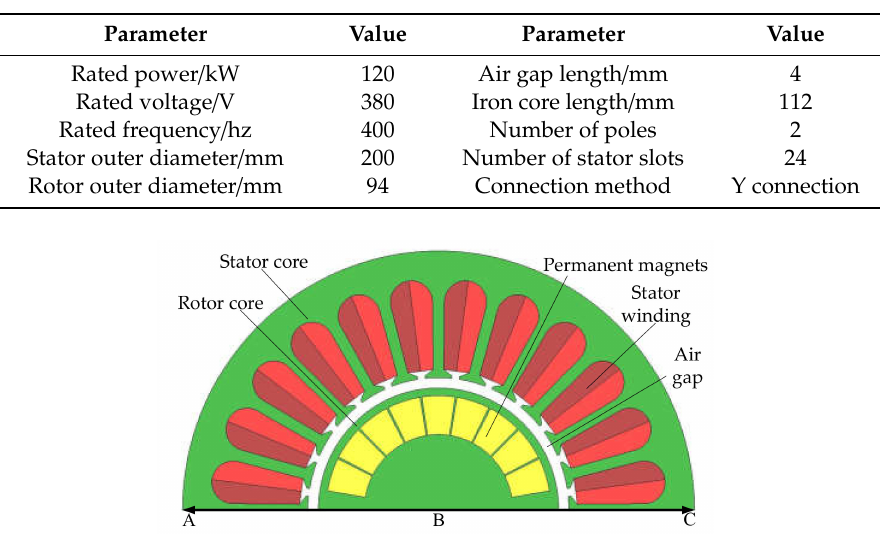
Table 1. Parameters of prototype motor.